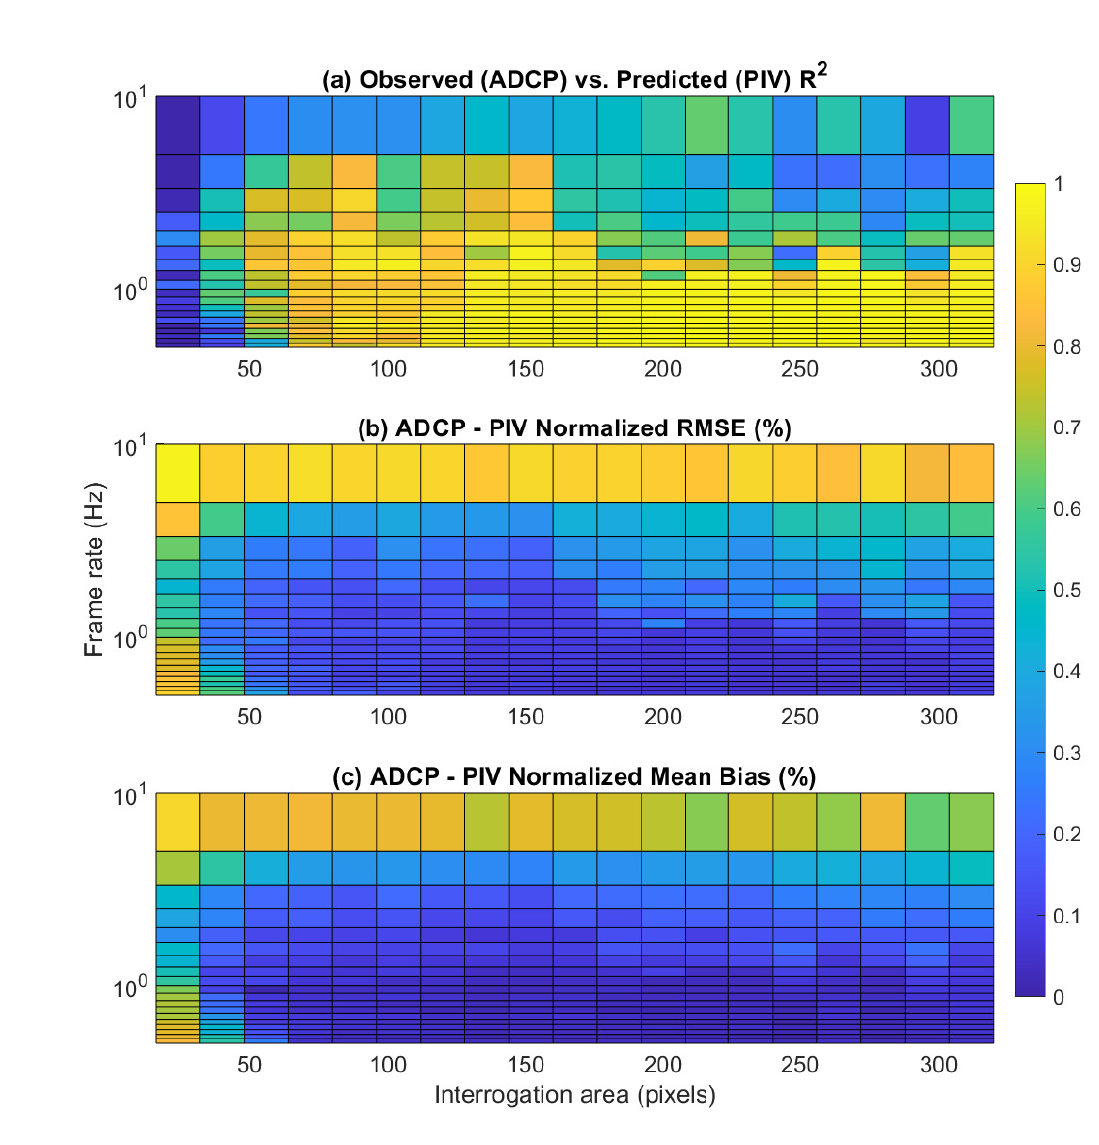
Figure 8. Parameter Optimization for PIV (POP) results for video sequences from the Tanana River. ( a ) Observed (ADCP) versus predicted (PIV) regression R 2 values. ( b ) Normalized Root Mean Squared Error (RMSE) between field-measured ADCP and PIV-derived velocities. ( c ) Normalized mean bias between field-measured ADCP and PIV-derived velocities. RMSE and mean bias are normalized by the mean of the ADCP velocity measurements. Note that for display purposes the normalized RMSE and mean bias values in panels ( b , c ) are expressed as proportions between 0 and 1 and not as percentages between 0 and